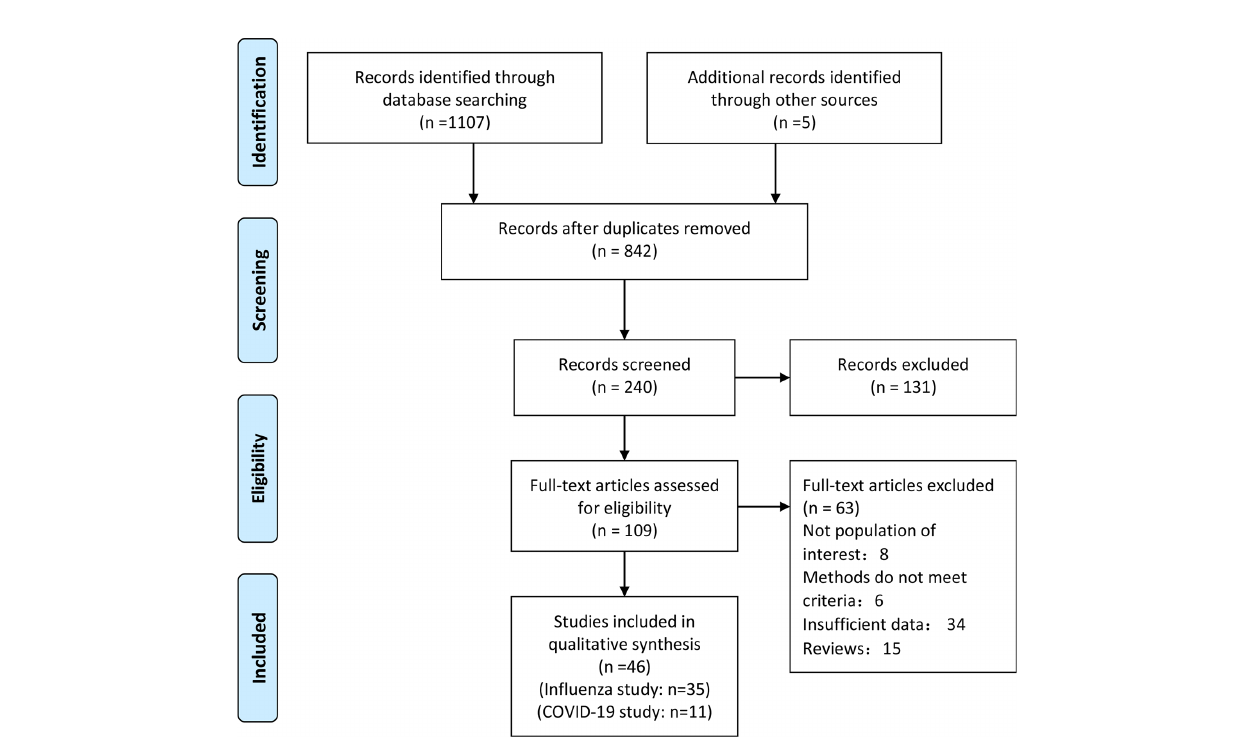
FIGURE 1 | Flowchart on the literature selection process in this